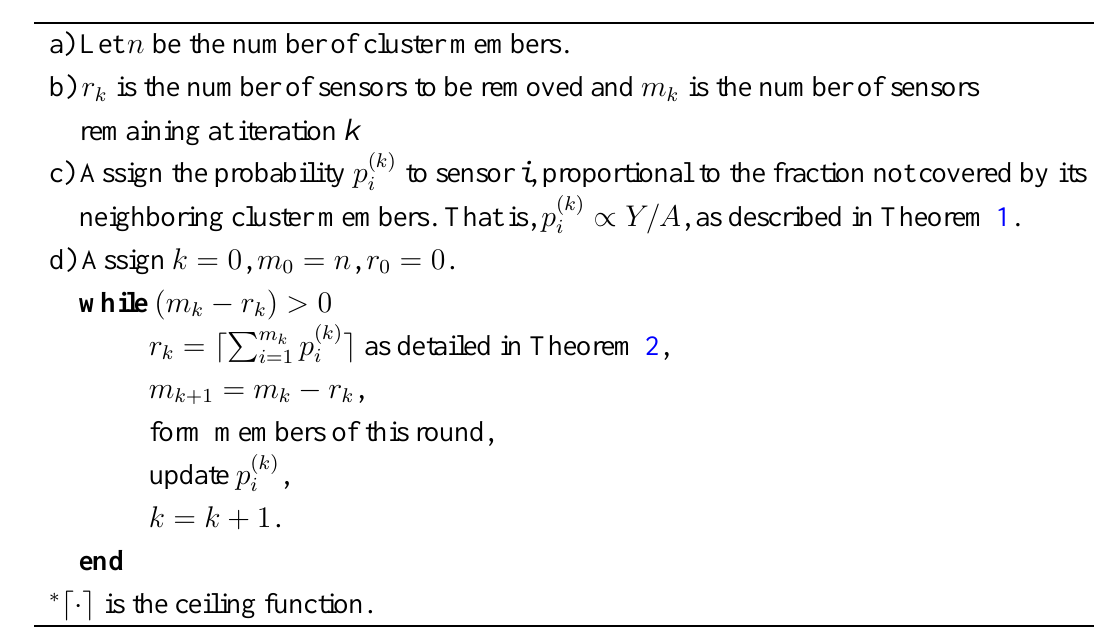
Table 2. Procedures of the PM model for analyzing the